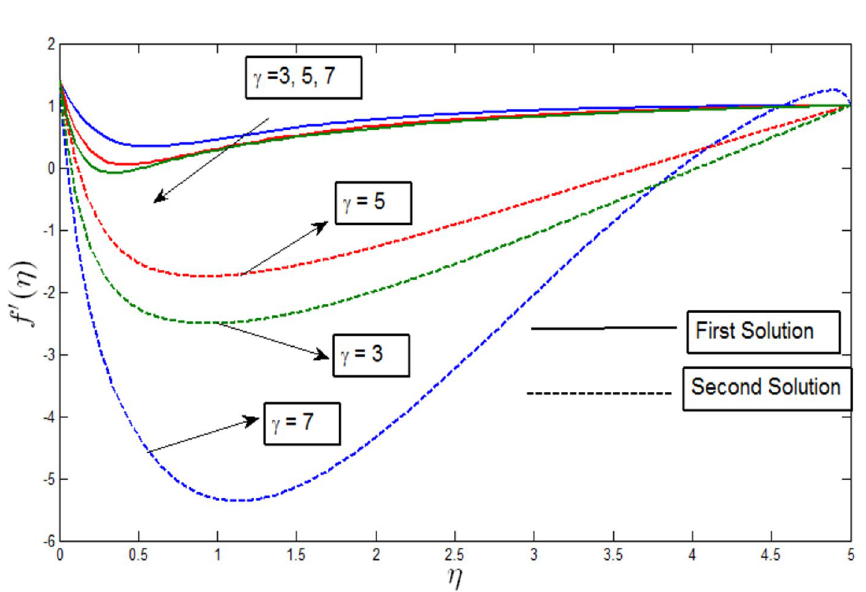
′ (η) Figure 5. Velocity profile f for various γ when (cid:31) = − 4, Lb = 0.5, Le = 0.5, Pb = 0.5, Nr = 0.5, Rb = 0.6, A =